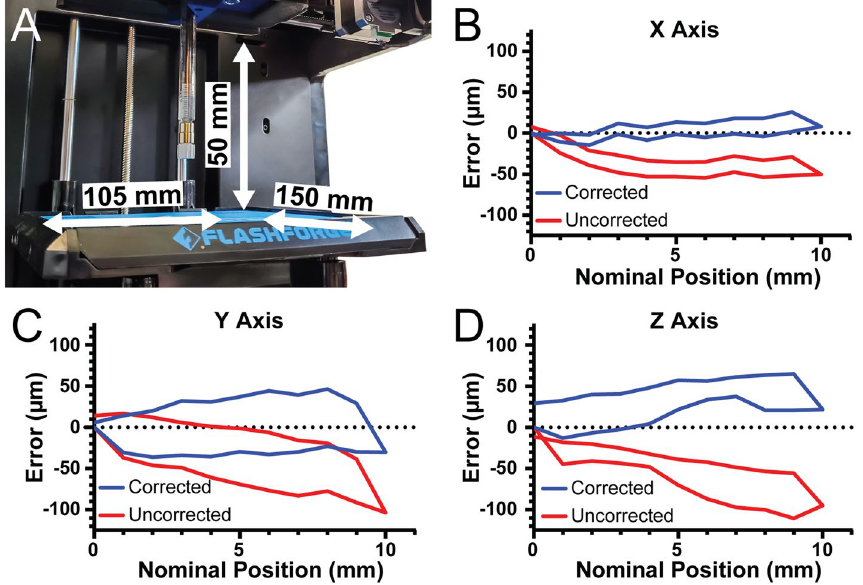
Figure 3. Measurement and correction of printer travel. ( A ) The X-axis travel is 105 mm, the Y-axis travel is 150 mm, and the Z-axis travel is 50 mm. ( B ) The error of travel for the X-axis across a 10 mm window before correction (red) and after correction (blue). ( C ) The error of travel for the Y-axis across a 10 mm window before correction (red) and after correction (blue). ( D ) The error of travel for the Z-axis across a 10 mm window before correction (red) and after correction